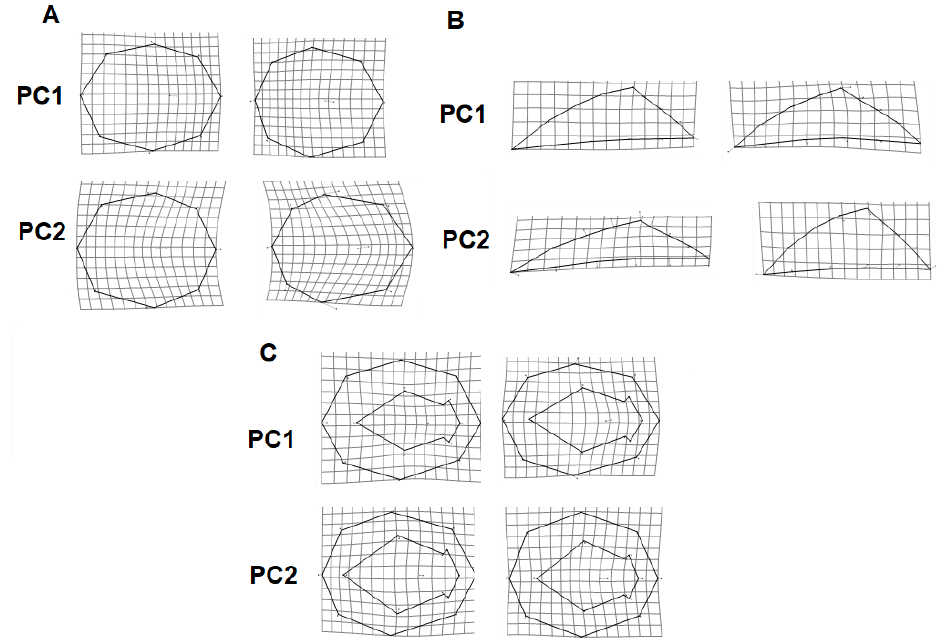
Figure 3. Wireframe visualization of the maximum and minimum shape of the principal component 1 and 2, comparing the ( A ) dorsal, ( B ) lateral, and ( C ) ventral view of Lottia mesoleuca species and their respectively negative (left) and positive (right) wireframe visualization of the average shape for geographical shape variation.